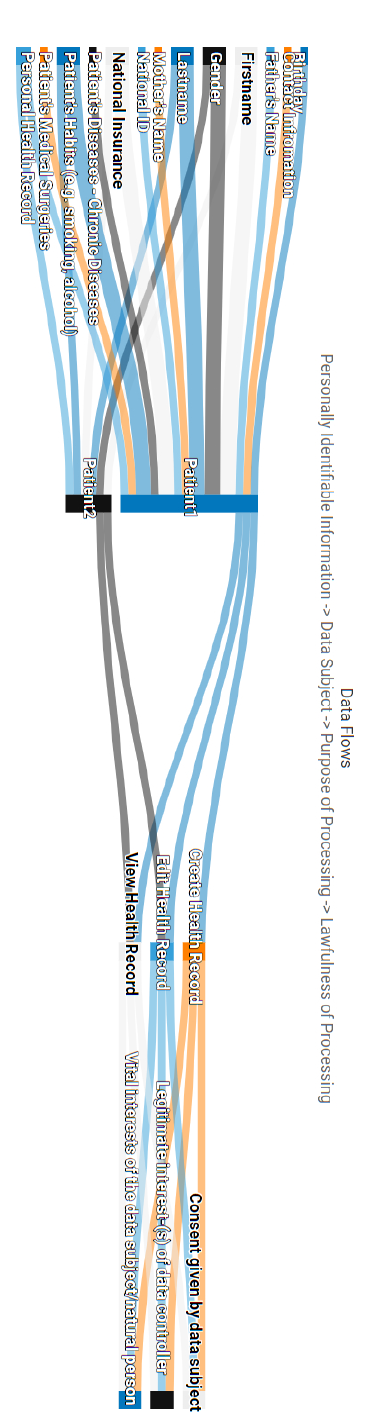
Figure A1. Data processing flows in the frame of